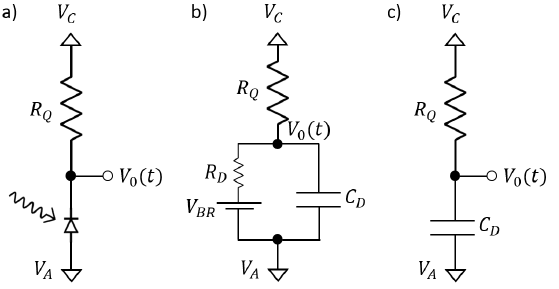
quenching; ( c ) equivalent circuit of passive